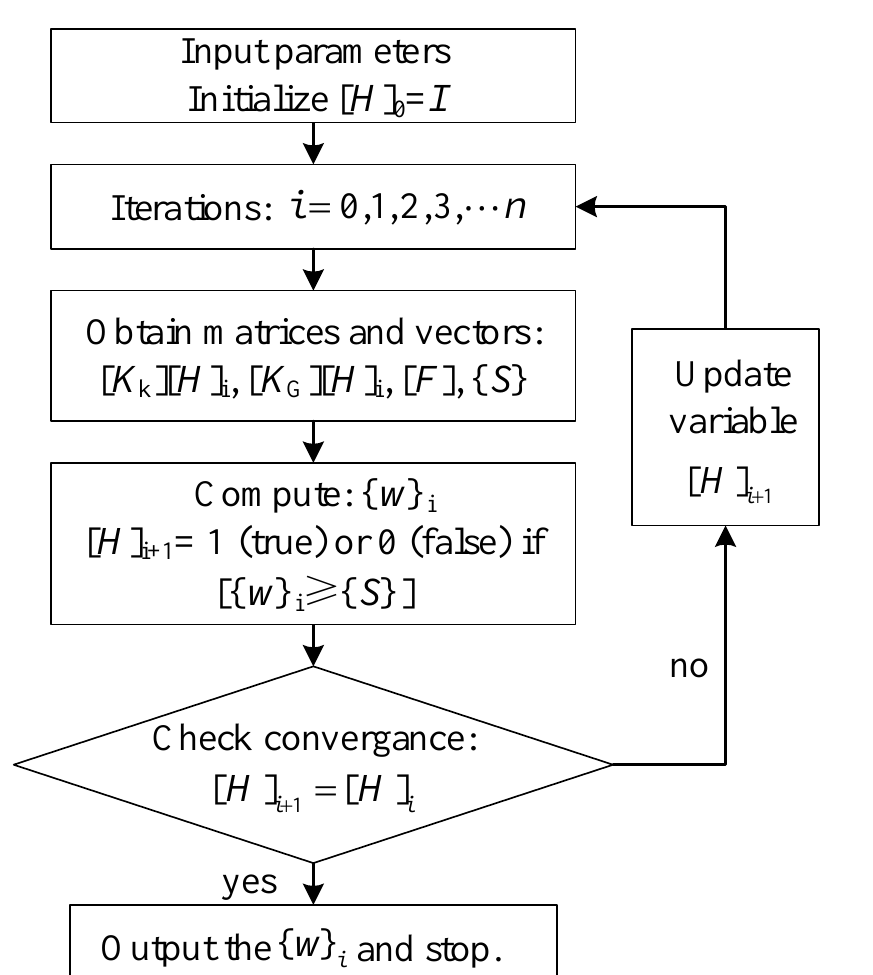
Figure 8. Nonlinear solution procedure based on Newton–Raphson method. First, input the calculation parameters and initialize the matrix [ H ] as the identity matrix. Second, obtain the matrices and vectors in Equation (30). Third, compute the displacement vector { w } and compare the vector { w } with the vector { S } to obtain [ H ] as in Equation (28h). Fourth, update [ H ] and recalculate { w } until the convergence criterion is achieved.